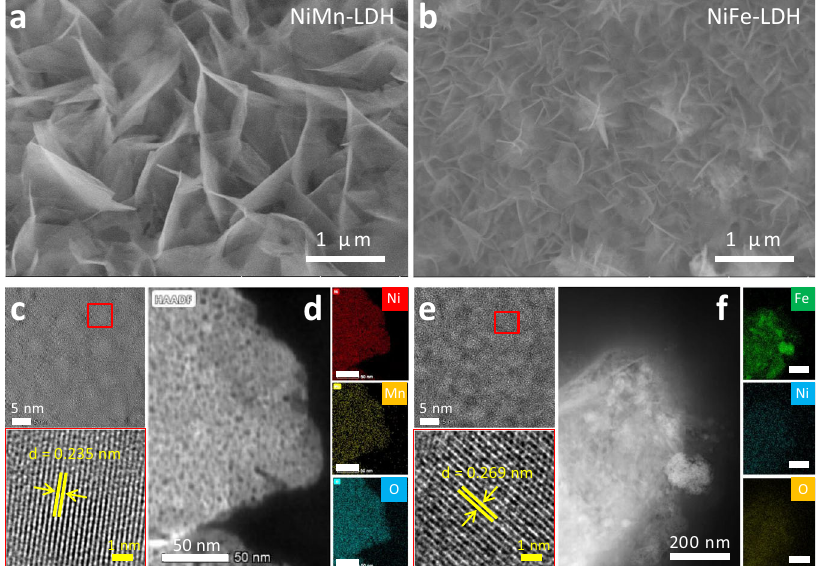
Fig.1|Preparationandcharacterizationsofthecatalysts. SEMimagesofthe a NiMnand b NiFe-LDHs.HR-TEMandHAADF,elementalmappingimagesof c , d NiMnand e , f